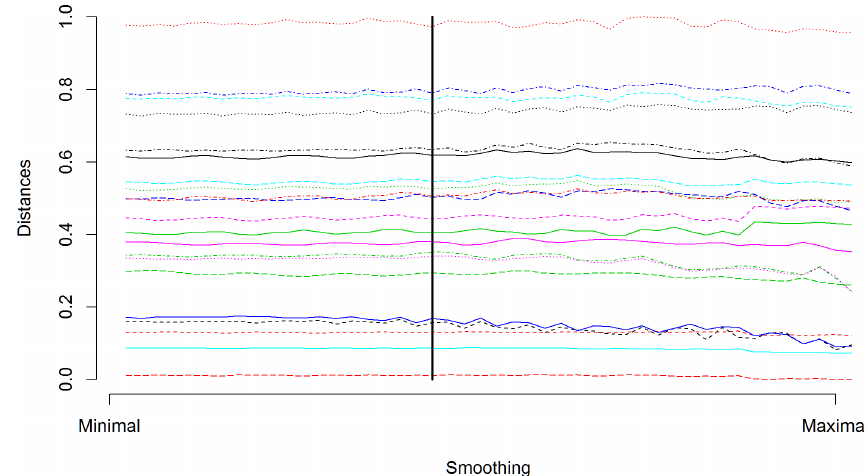
Figure 4. Normalized d 0 distances between simulated air temperature curves (data are shown in Fig. 1a) of randomly selected model and other models, which depend on amount of smoothing. Starting values represent d 0 distances between original curves, and values at the end represent d 0 distances for oversmoothed data. The vertical line depicts the amount of smoothing used in the presented study.